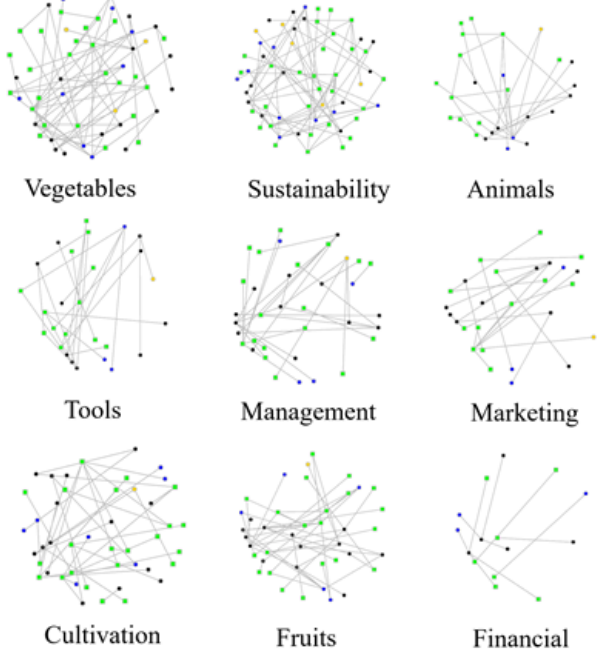
Individual Sub-Networks Based on Topics of Sustainability